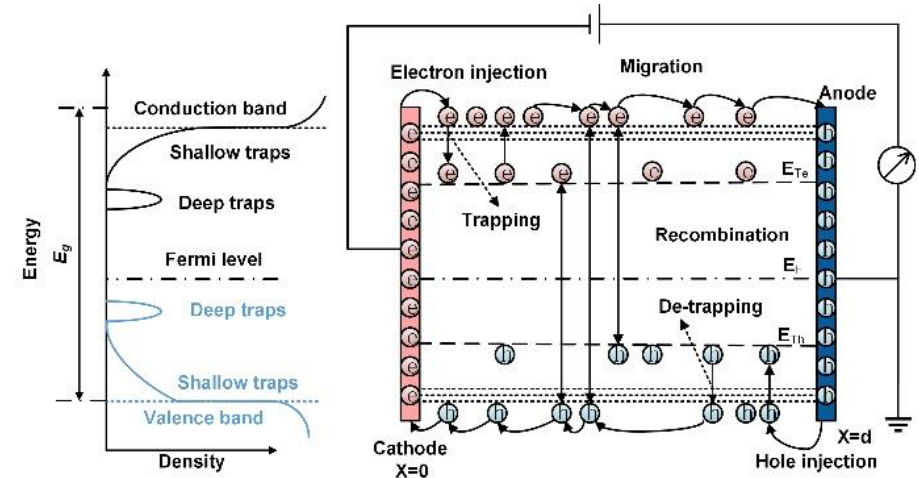
Figure 1. Scheme of BCT model of the polymeric materials, E Te and E Th are the trap energy of the electrons and holes, respectively.